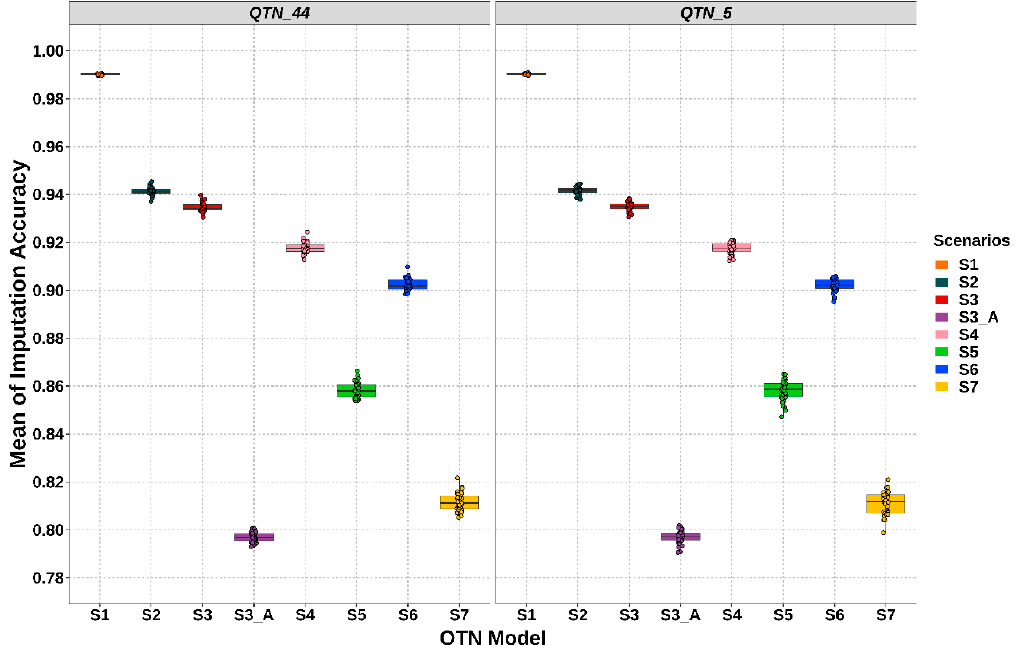
Figure 3. Imputation accuracy for each imputation strategy within QTN models. “S” stands for scenario. QTN_5 stands for the QTN model with 5 QTNs per chromosome and QTN_44 stands for the QTN model with 44 QTNs per chromosome. The simulated rabbit genome comprised 20 chromosomes. Each dot stands for a simulation value within each scenario.